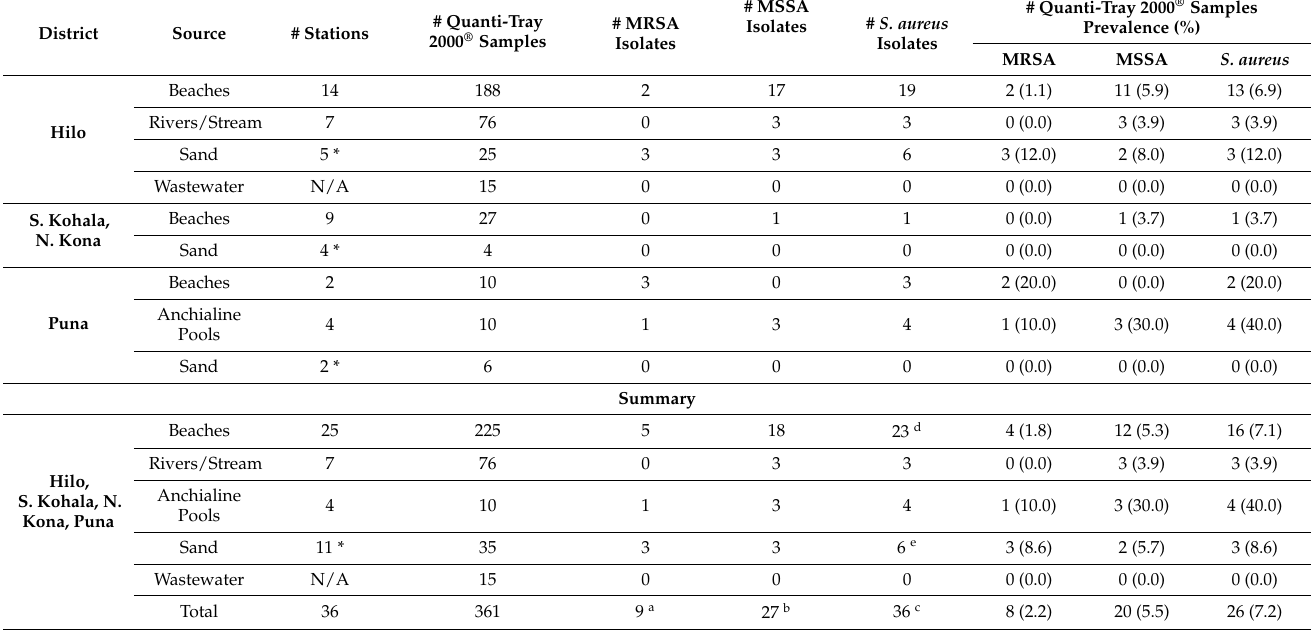
Table 1. Distribution and prevalence of Staphylococcus aureus samples (n = 26) and isolates (n = 36) characterized from environmental sources. Methicillin-resistant S. aureus (MRSA); methicillin-susceptible S. aureus